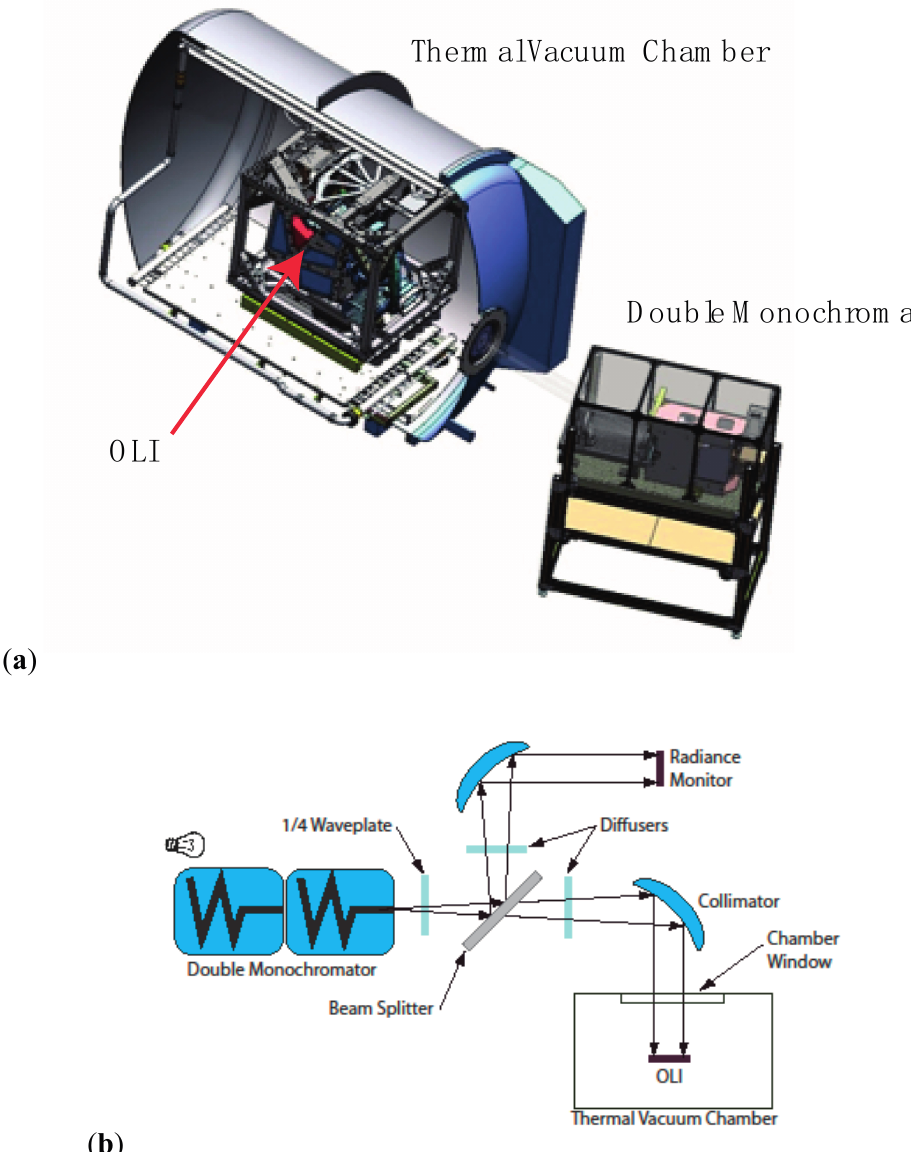
Figure 8. Test setup for OLI instrument level spectral testing; ( a ) The OLI is inside a thermal vacuum chamber with the entrance aperture aligned with the window on the chamber. The OLI detectors are looking at the output of a double monochromator, one module at a time; ( b ) A tungsten halogen lamp illuminated the input slit of a double monochromator. At the output slit of the monochromator a beam splitter sent part of the light to a monitor detector and part through a collimator and a window in the thermal vacuum chamber to the